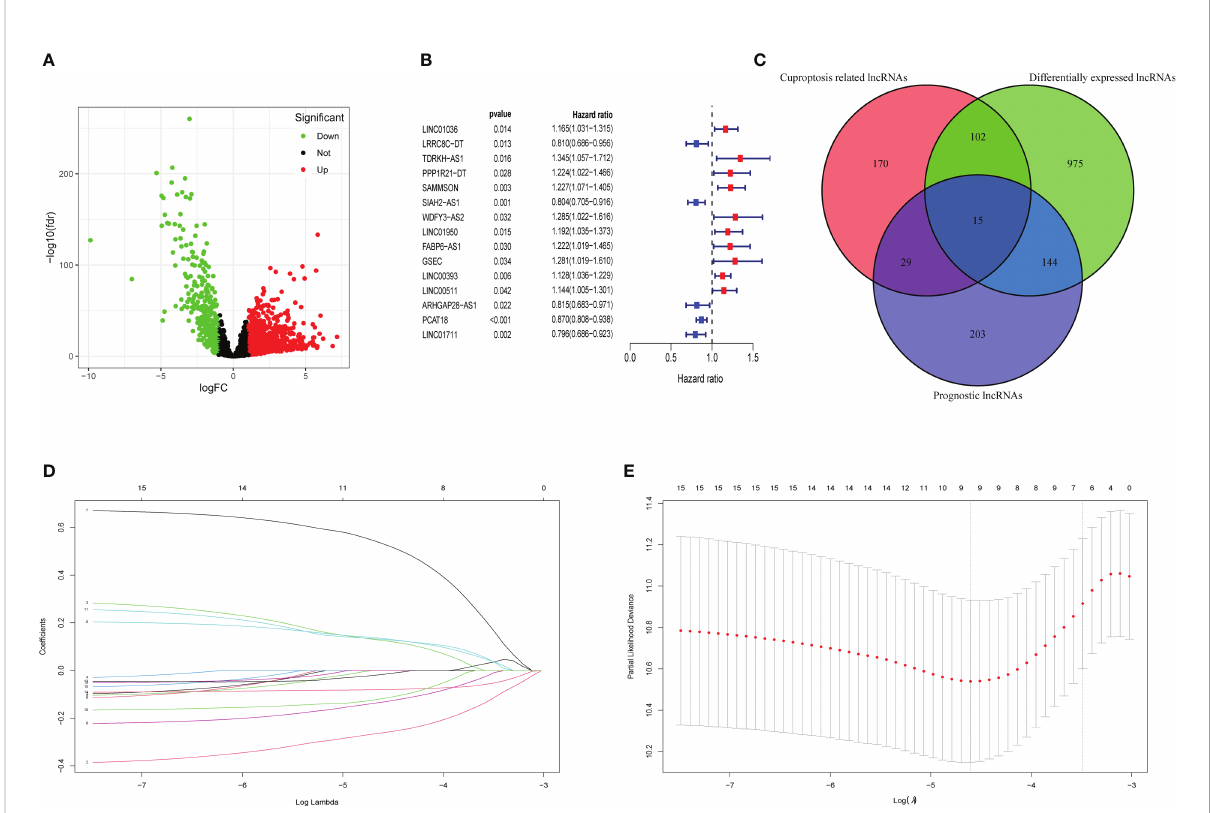
FIGURE 2 Collection of prognostic differential expression cuproptosis-related lncRNAs. (A) Volcano plot of differentially expressed lncRNAs. The downregulated lncRNAs are indicated by green spots, while the upregulated ones are indicated by red spots. (B) The HR (95% CI) and p-value of 15 collected prognosis- related lncRNAs. (C) The intersections of differentially expressed lncRNAs, prognosis-related lncRNAs, and cuproptosis- related lncRNAs were selected as the candidates. (D) LASSO coef fi cient pro fi les of 15 lncRNAs with p< 0.01. (E) Fivefold cross-validation results identi fi ed the optimal value of the penalty parameter l . LASSO, least absolute shrinkage and selection operator; lncRNA, long non-coding